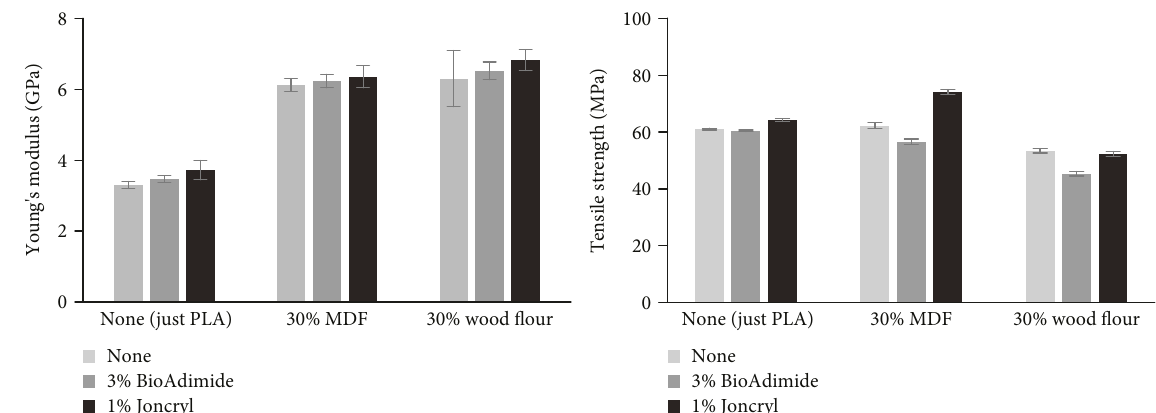
Figure 7: E ff ect of chain extender additives on tensile modulus and maximum tensile strength of injection moulded PLA NFC test samples. 1wt % Joncryl® and 3 wt % BioAdimide®, on the modulus and strength of a plain PLA. PLA containing 30 wt % of MDF fi bre and PLA containing 30wt % wood fl our (error bars= ± 95% con fi dence interval) ( n = 10 ).